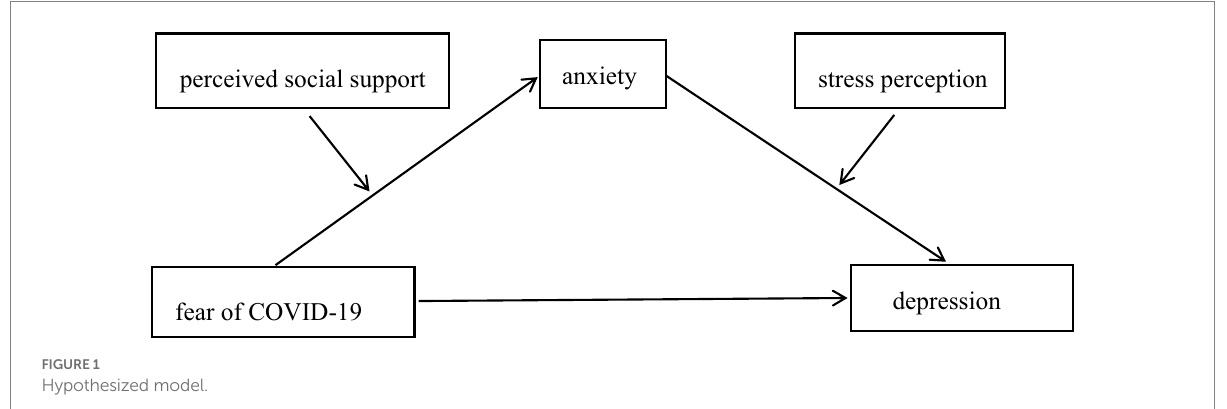
FIGURE 1 Hypothesized